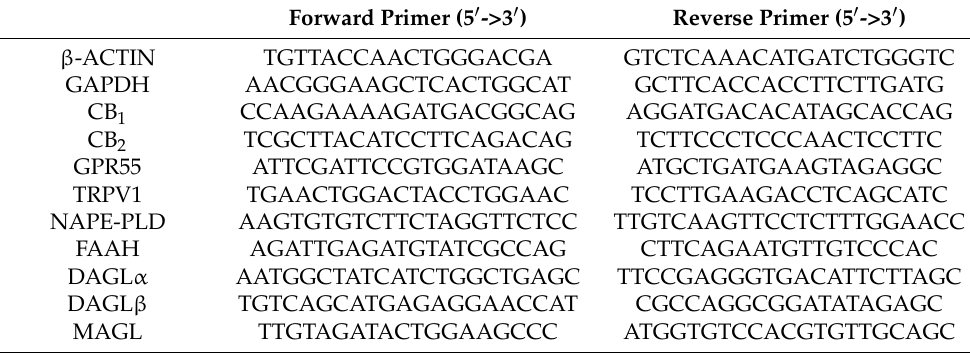
Table 1. List of the primers used to assess the relative abundance of eCB-binding receptors and metabolic